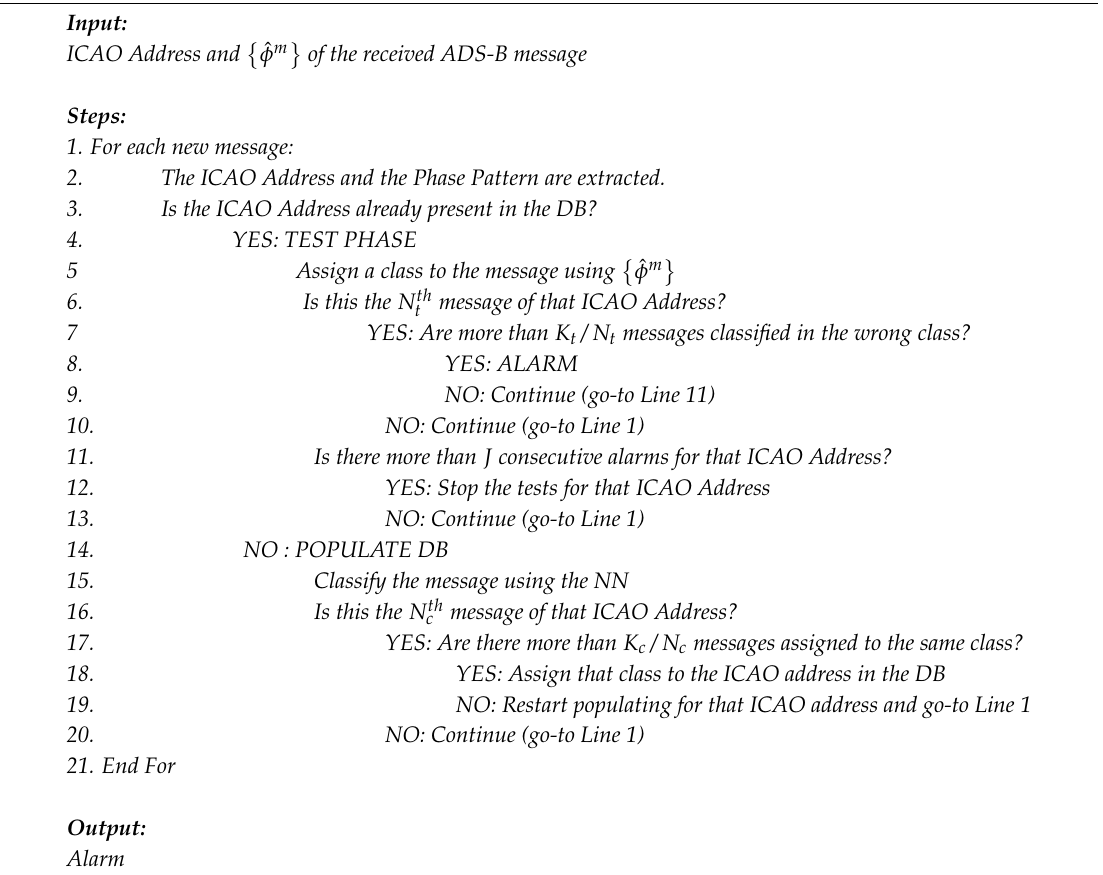
Algorithm 2: Intruder